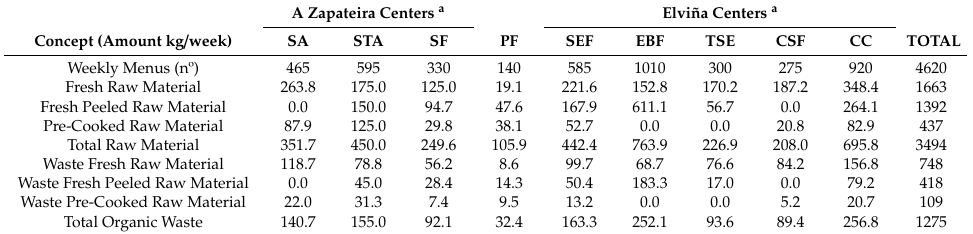
Table 1. Waste generation produced in the canteens of the UDC campus at Elviña and A Zapateira. A Zapateira Centers a Elviña Centers